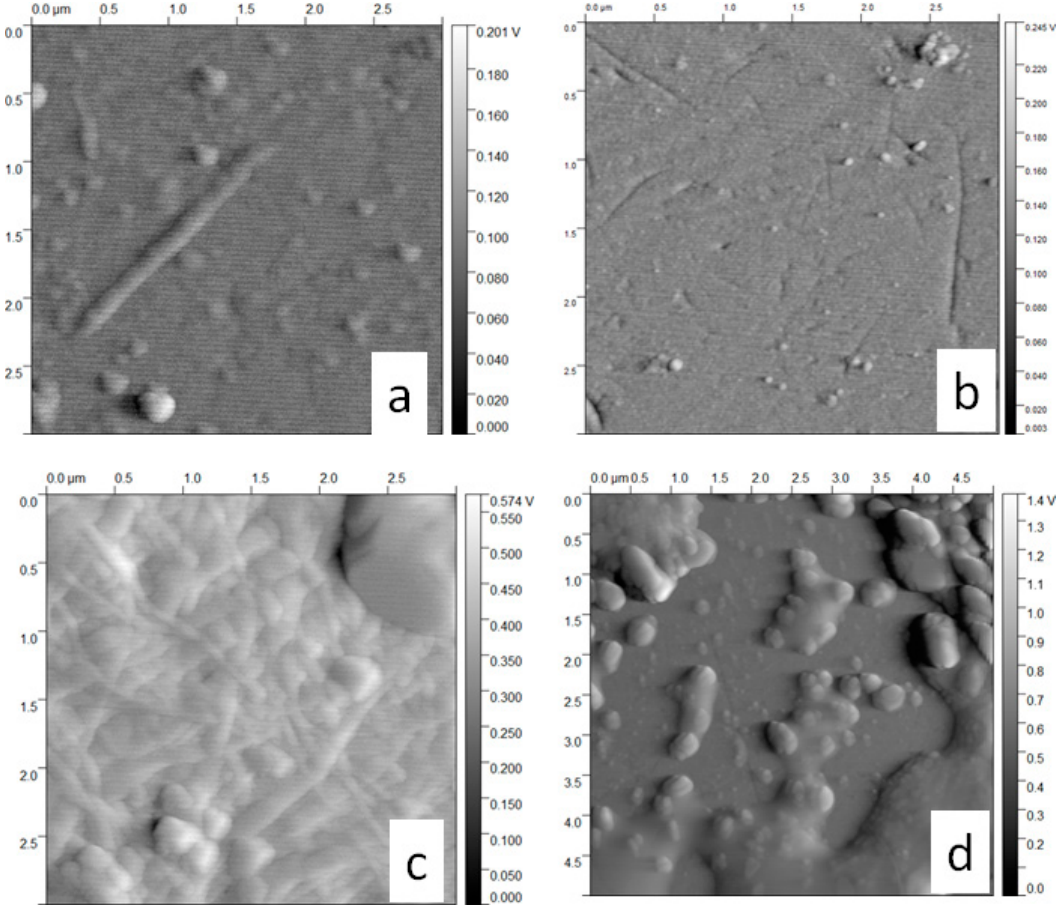
Figure 5. Interaction vitamin B12 vs. BNC AFM images. Adsorption: ( a ) BNC Adsorption; ( b ) BNC Desorption; ( c ) B12 Adsorption; ( d ) B12 Desorption.